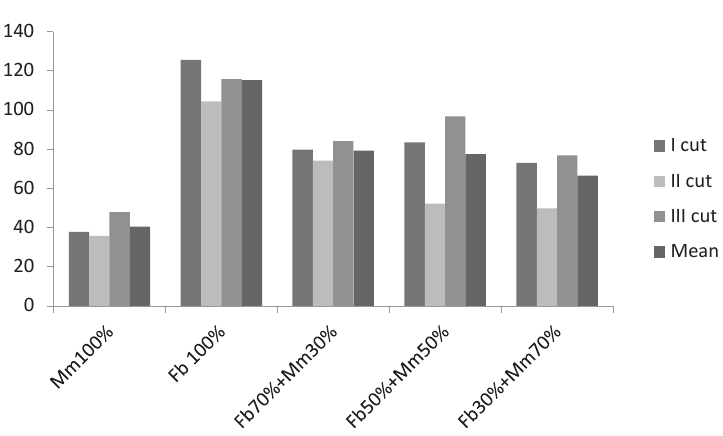
Fig. 3. Content of water-soluble carbohydrates (average for years)